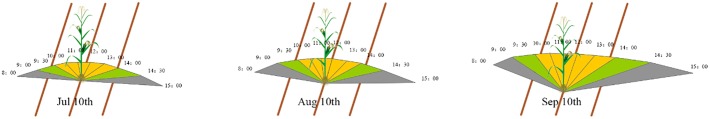
The horizontal shadow distance at different times.